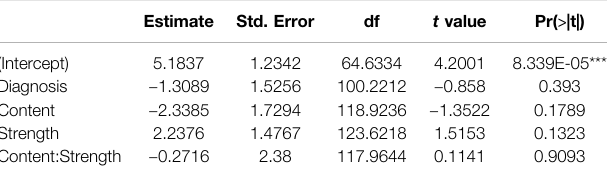
TABLE 5 | Coef fi cient table of the model used to probe the effect of depression diagnosis(Diagnosis; 0 (cid:1) nodepression diagnosis,1 (cid:1) depression diagnosis), content (Content; 0 (cid:1) sacri fi ce, 1 (cid:1) save), and strength (Strength; 0 (cid:1) weak, 1 (cid:1) strong) on skin conductance rates during initiating utterances. The marginal R 2 for the model was 0.05 and the conditional R 2 was 0.20.